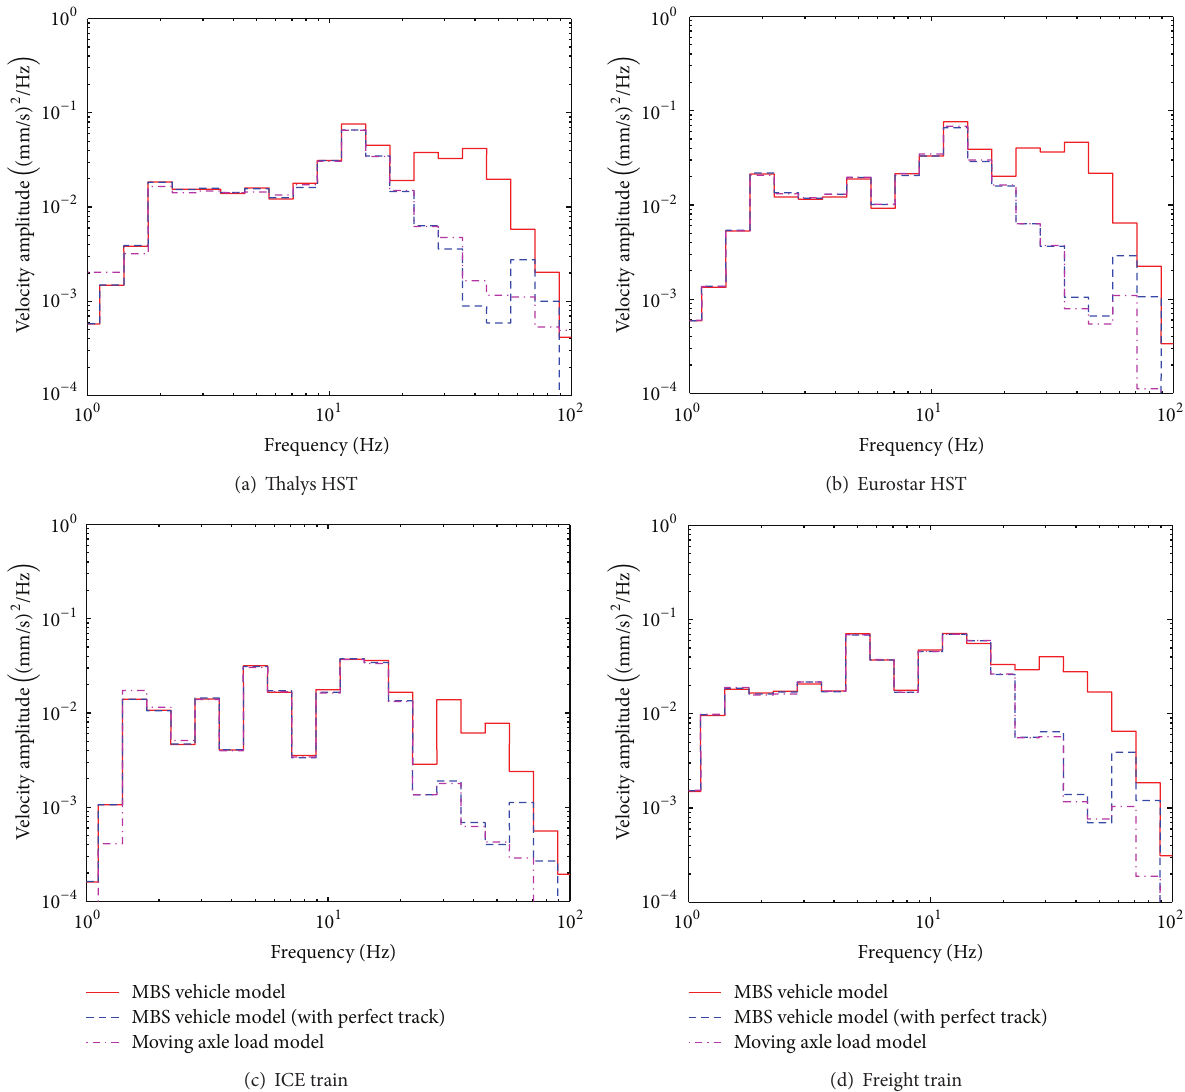
Figure 10: One-third octave band spectra of vertical ground surface velocity induced by the four studied trains, at 10 m from the track, for a vehicle speed of